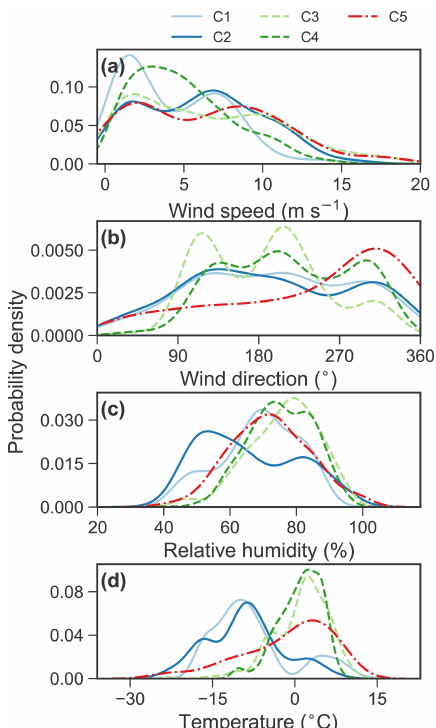
Figure A5. Probability density distribution of the meteorological conditions for aerosol volume concentrations that exceeded their 90th-percentile values within each cluster.